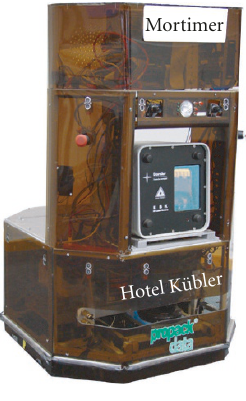
Figure 6: Mobile service robot